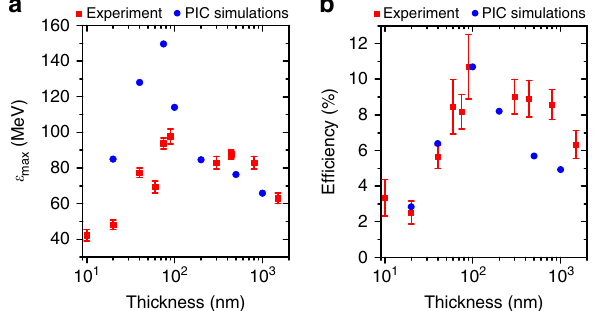
Fig. 3 Scaling of the maximum proton energy and energy conversion ef fi ciency with thickness. Measured a maximum proton energy ( ε max ) and b laser-to-proton energy conversion ef fi ciency ( η ), as a function of foil thickness (red), together with results from 2D PIC simulations (blue). The conversion ef fi ciencies from the simulations are scaled by a fi xed value, such that the maximum value is normalised to the measured maximum ef fi ciency. The maximum energies from the simulations are unscaled. Both proton beam parameters are maximised at an optimum target thickness range of 70 – 100 nm. The error bars in the maximum energy are de fi ned by the energy corresponding to the last RCF layer for which proton signal is measured (lower limit) and the energy of the next RCF layer (upper limit). The error bars in the conversion ef fi ciency are determined from the uncertainties in the measured proton energy